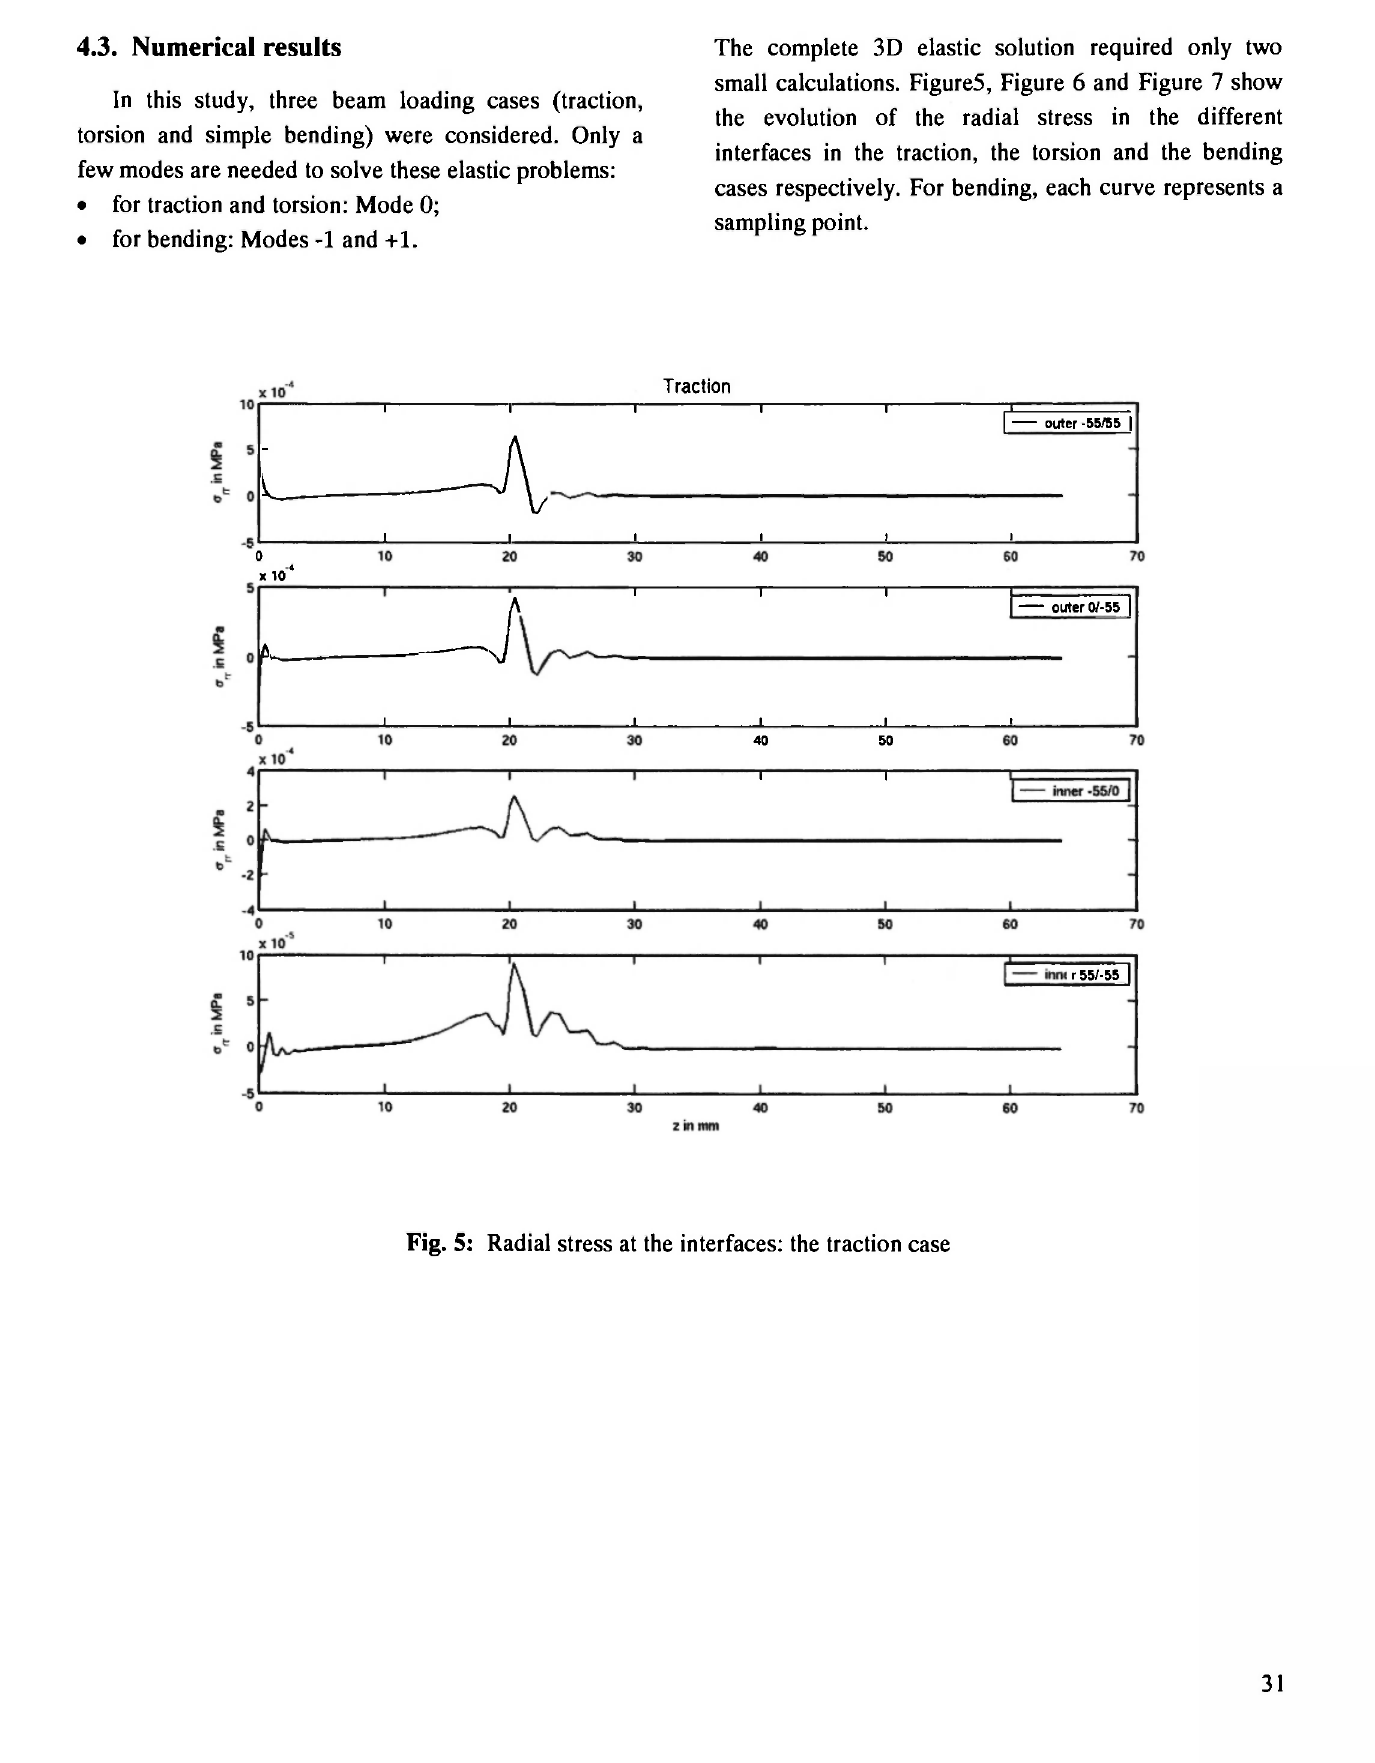
Fig. 5: Radial stress at the interfaces: the traction